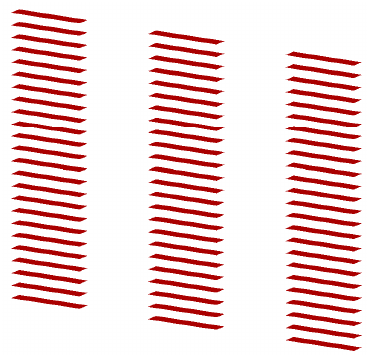
Figure 3. Venetian-type Figure 3. V enetian-type blind.